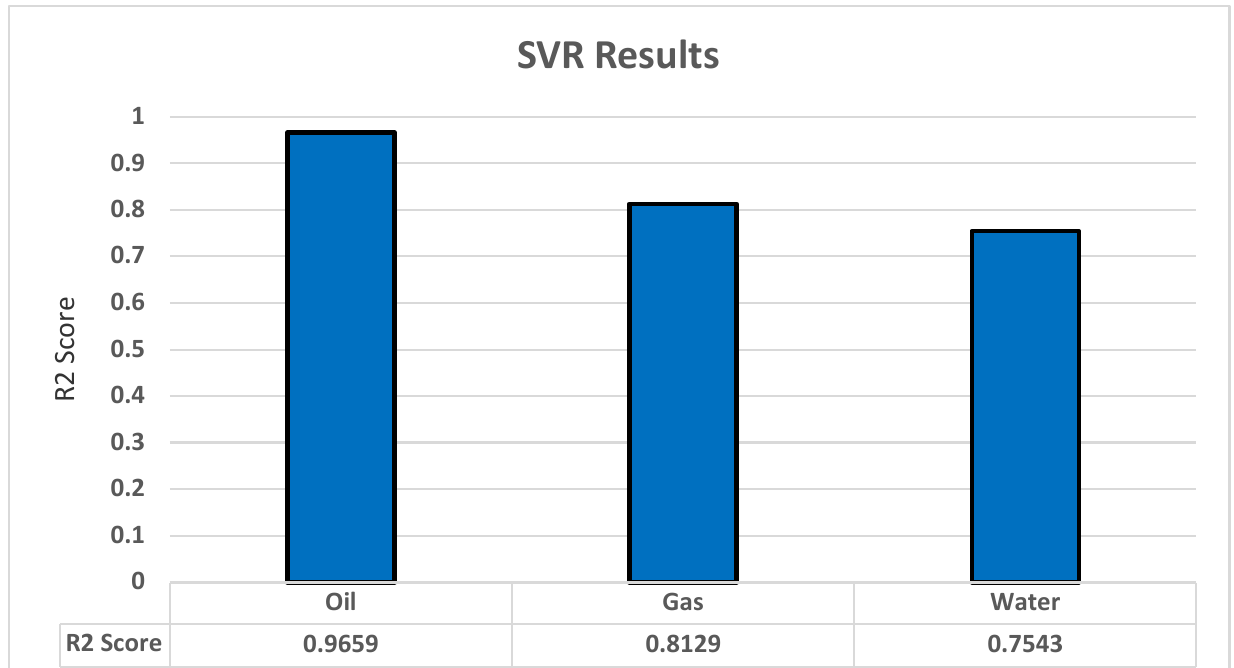
SVR: Comparison of R2 scores for oil, gas, and water Figure 6. SVR’s R2 score results. Figure 6. SVR’s R2 score